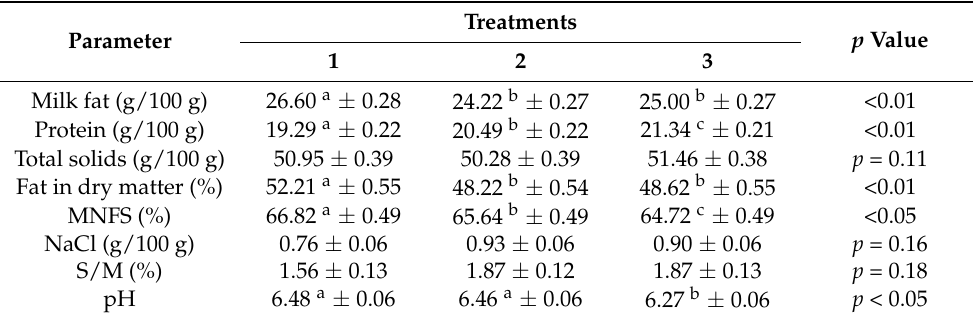
Table 3. Effect of milk standardization on physicochemical characteristics of Liˇcki škripavac cheese (least square means ± standard